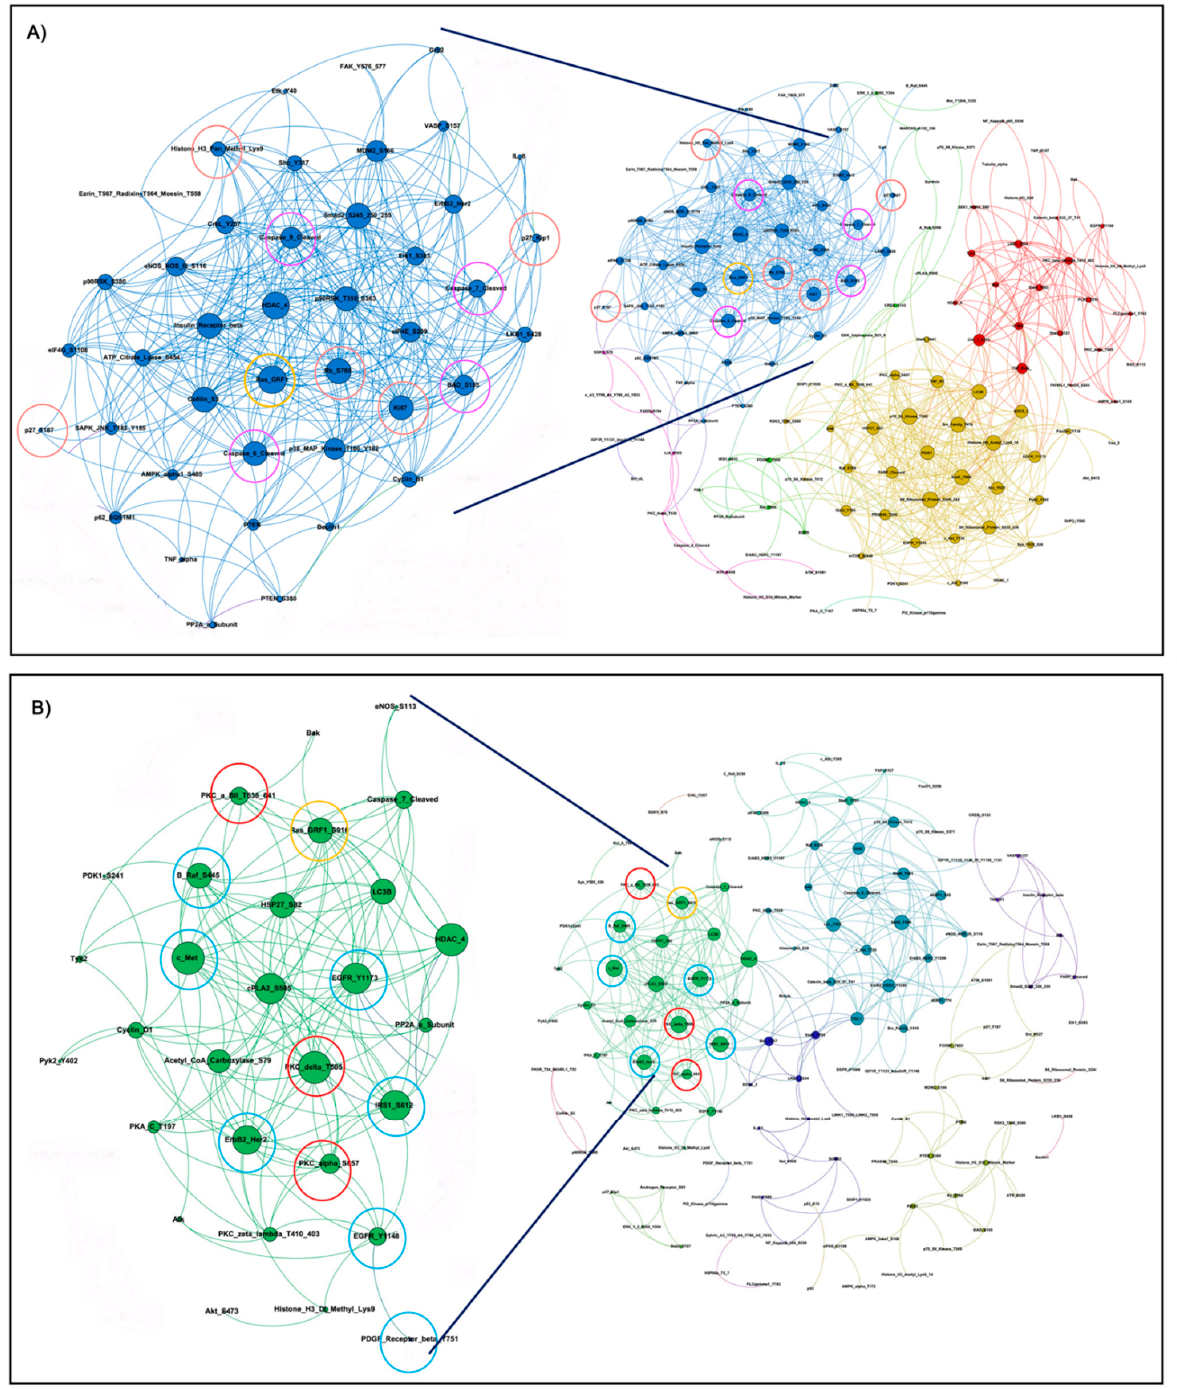
Figure 3. Interaction networks of signal transduction molecules in KRASm/WT − and KRASm/WT+ NSCLC models. Spearman rank-order correlation coefficients of RPPA-based continuous values greater than 0.90 across the 183 measured analytes are displayed using network maps. Protein networks of KRASm/WT − (A549, H2122) show high levels of interaction with most proteins contained within three main clusters ( A ). Cell cycle regulators and proteins belonging to the apoptotic pathway are highlighted with red and pink circles, respectively. Network of KRASm/WT+ cell lines (H1734, H23, H358) shows fewer interconnections compared to the KRASm/WT − cells ( B ). Receptor tyrosine kinase, MAPK signaling molecules and members of the PKC family are highlighted in red and green, respectively. Ras-GFR-1 is highlighted in yellow in both maps.